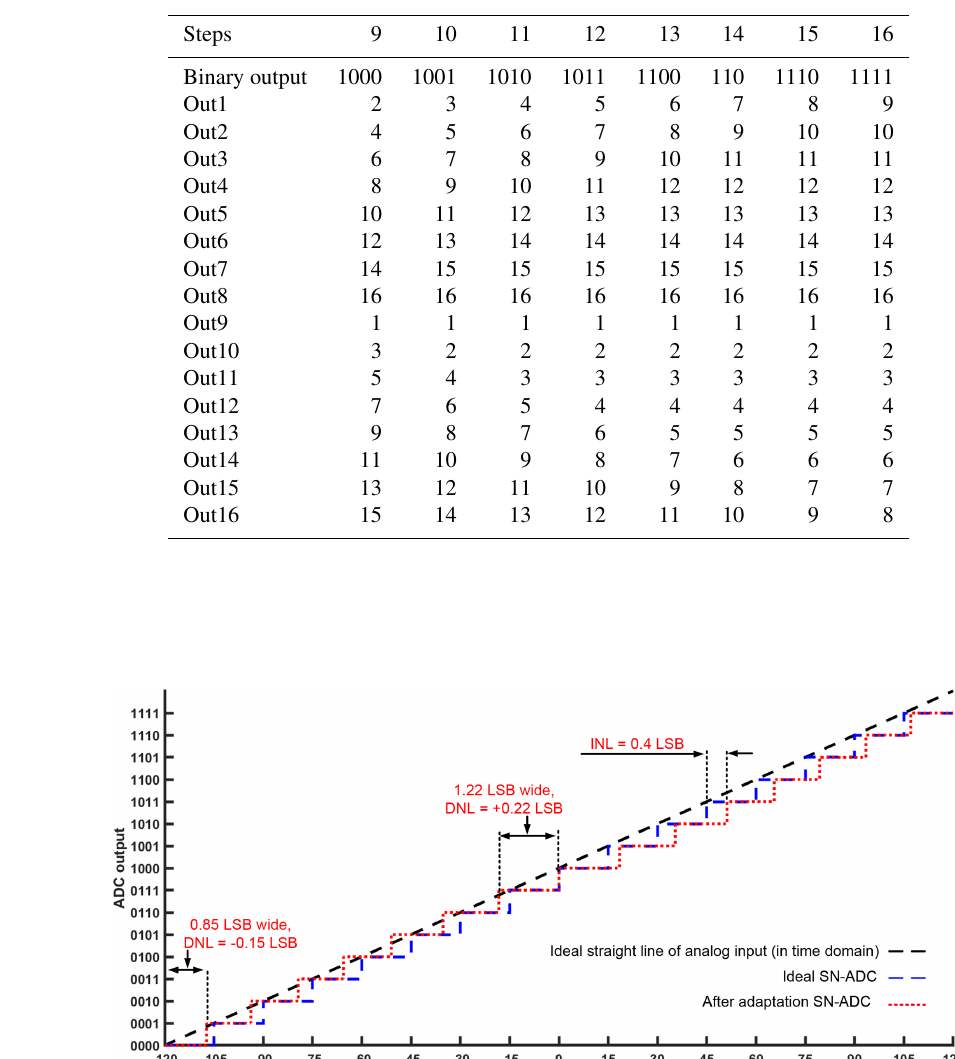
Table 2. ASRC output spike orders for the second eight steps.